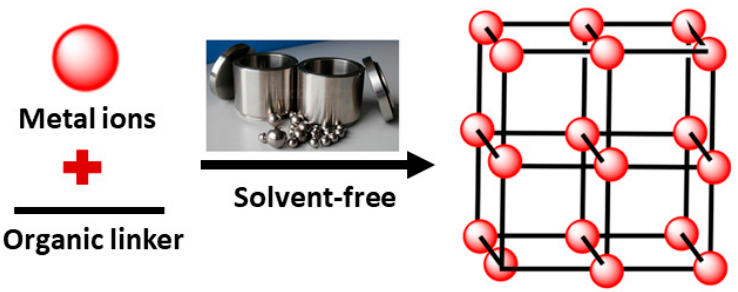
Figure 5. Mechanochemical synthesis of